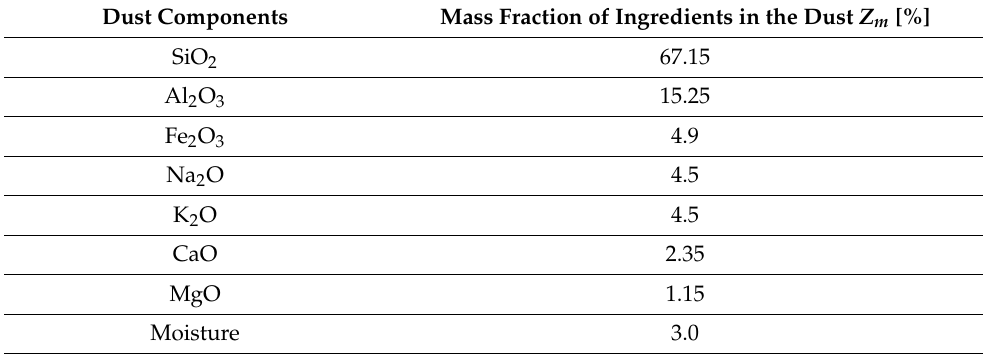
Table 2. Chemical composition of the test dust PTC-D